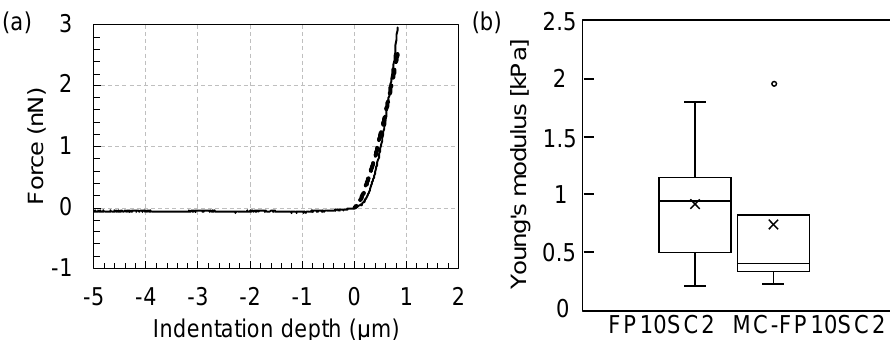
Figure 2. Changes in the Young’s modulus of cancer cells before and after stimulation with M Φ -CM. ( a ) Typical force–indentation curve (solid line) and a result of fitting based on Hertzian contact model (dashed line). R 2 = 0.952. ( b ) Comparison of Young’s moduli before (FP10SC2) and after the stimulation (macrophage-conditioned FP10SC2—MC-FP10SC2). P < 0.01.